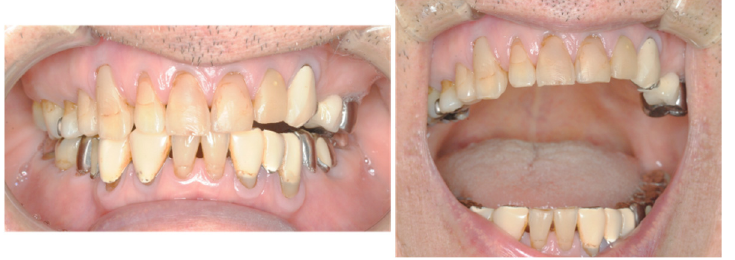
Figure 6. The degree of mouth opening improved to >40 mm, while the right-side mandibular de- viation observed during mouth opening